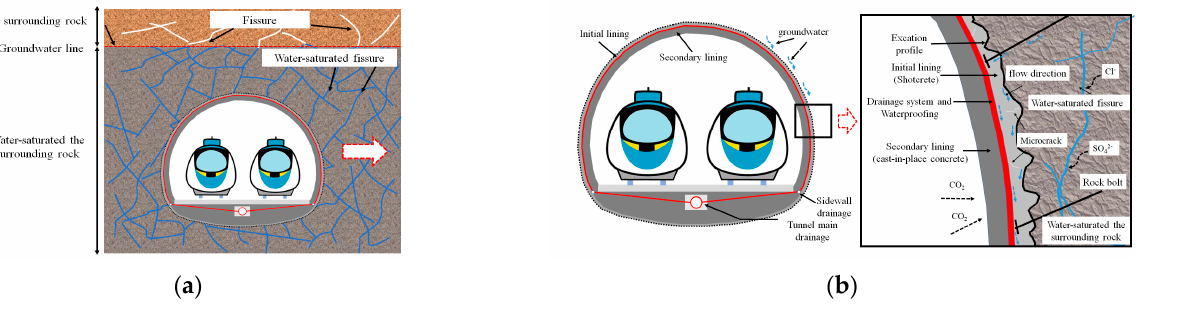
Figure 1. The composite lining structure of the drill-and-blast tunnel in the water-rich mountain: ( a ) water-rich mountain tunnel; ( b ) a composite lining structure of the tunnel.